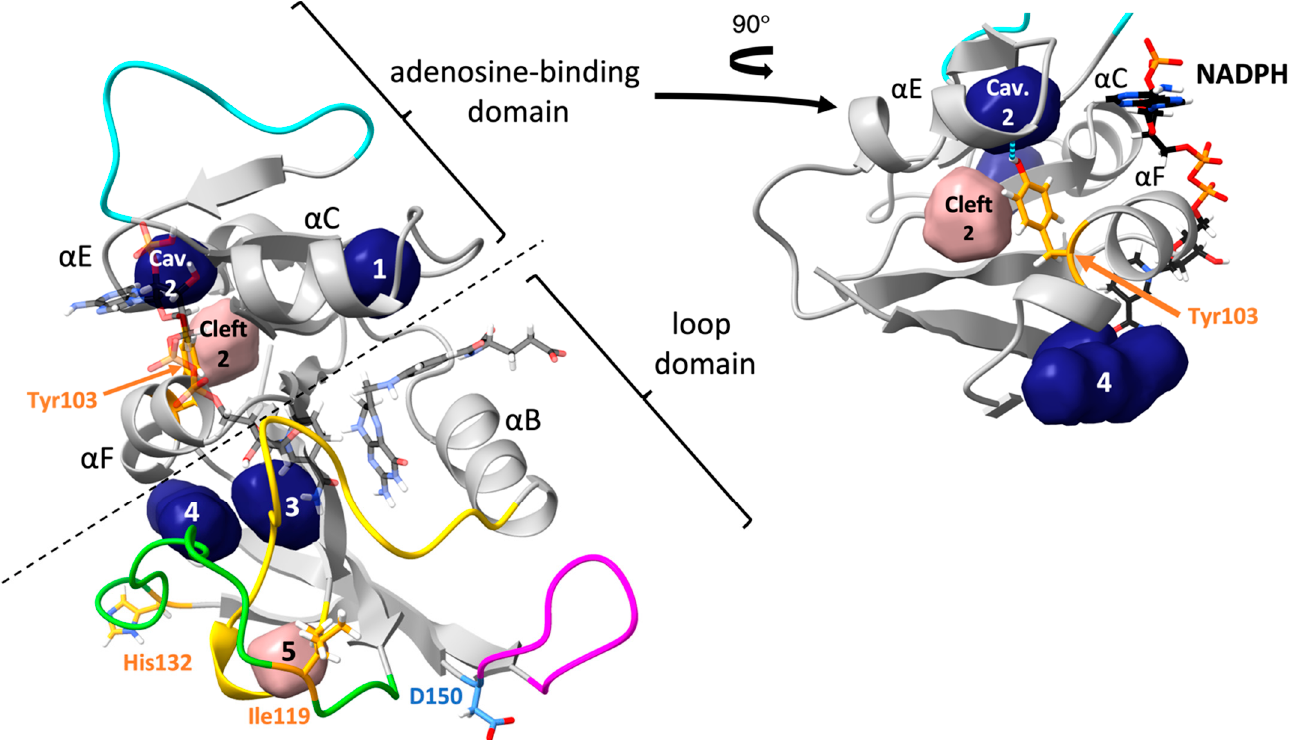
Figure 3. Cavities (dark blue) and clefts (pink) in Moritella DHFRs. Ribbon representation of MyDHFR. Unique residues of MyDHFR shown in wire. Cavities discussed in text near-unique residues of MyDHFR identified by arrows. Ligands NADPH and DHF shown in transparent CPK. Met20 (yellow), CD (cyan), FG (green) and GH (magenta) loops are also indicated. Right inset: rotated depiction of adenosine-binding domain with Tyr103 O η … Leu78 O hydrogen bond (blue dashed line). Table 3. Average and RMS fluctuations cavity or cleft volumes, V cav (Å 3 ).